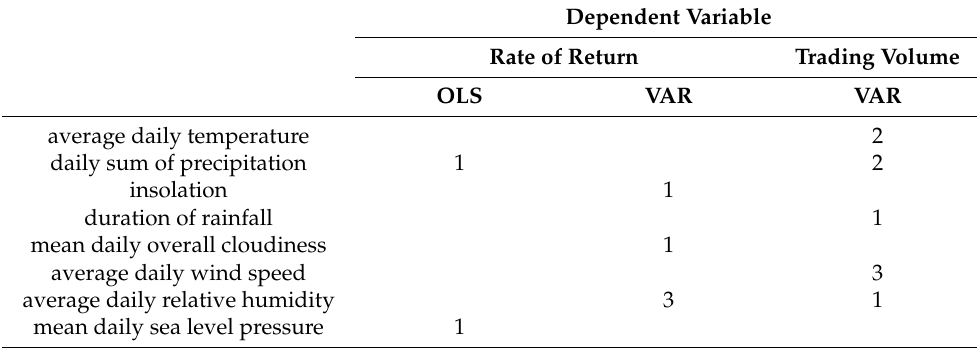
Table 8. The frequency of occurrence of the weather factor in the case of modeling the rate of return and the volume of trading in the cross-section of the methods